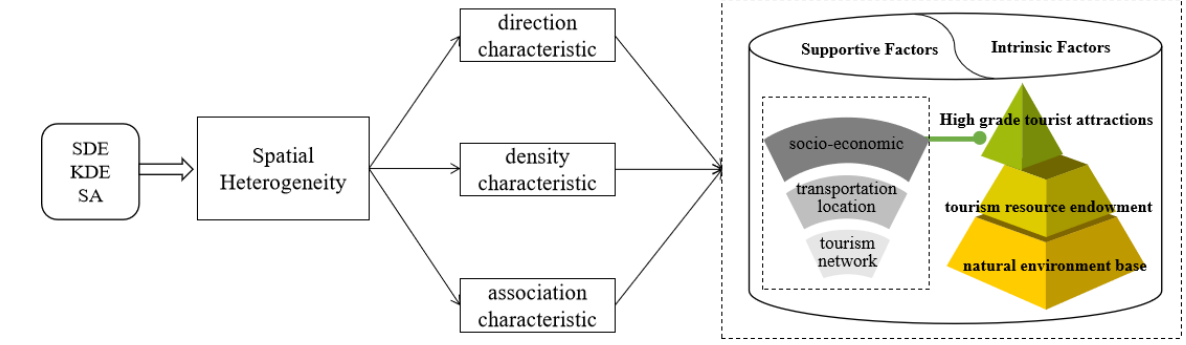
Figure 2. Research framework